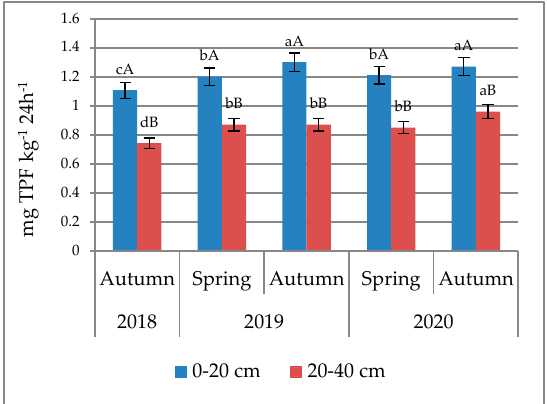
Figure 5. Activity of dehydrogenases (DEH) in the studied soil. Different lower-case letters indicate significant differences among the soil sampling seasons (2018 autumn, 2019 and 2020 spring, autumn). Different upper-case letters indicate significant differences among the levels of sampling. Error bars represent standard deviation.